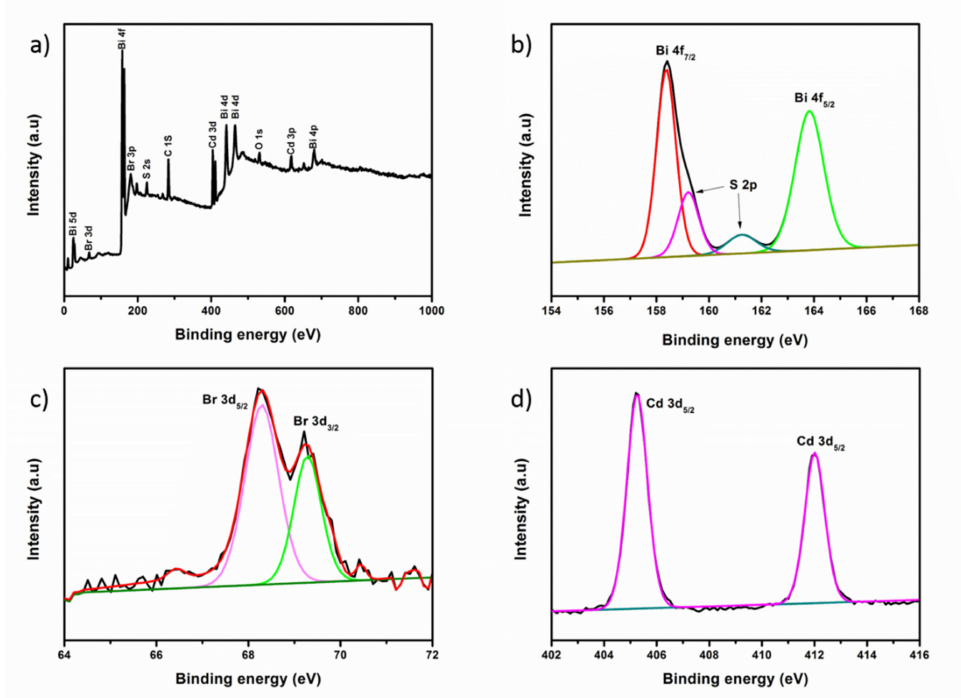
Figure 4. XPS spectra of BiOBr/Bi 2 S 3 /CdS: ( a ) full spectrum, ( b ) Bi 4f, ( c ) Br 3d, ( d ) Cd